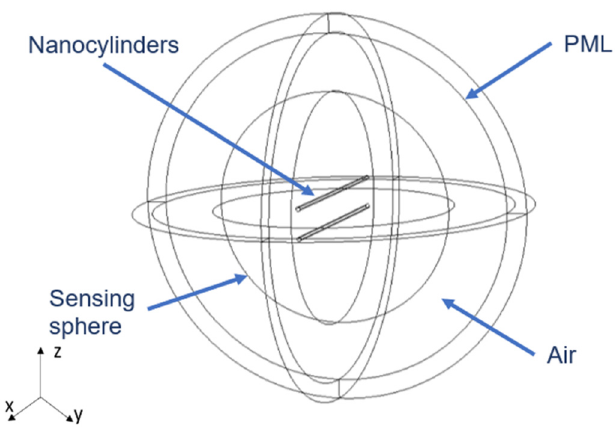
Figure 2. Scheme of the structure modeled in COMSOL.